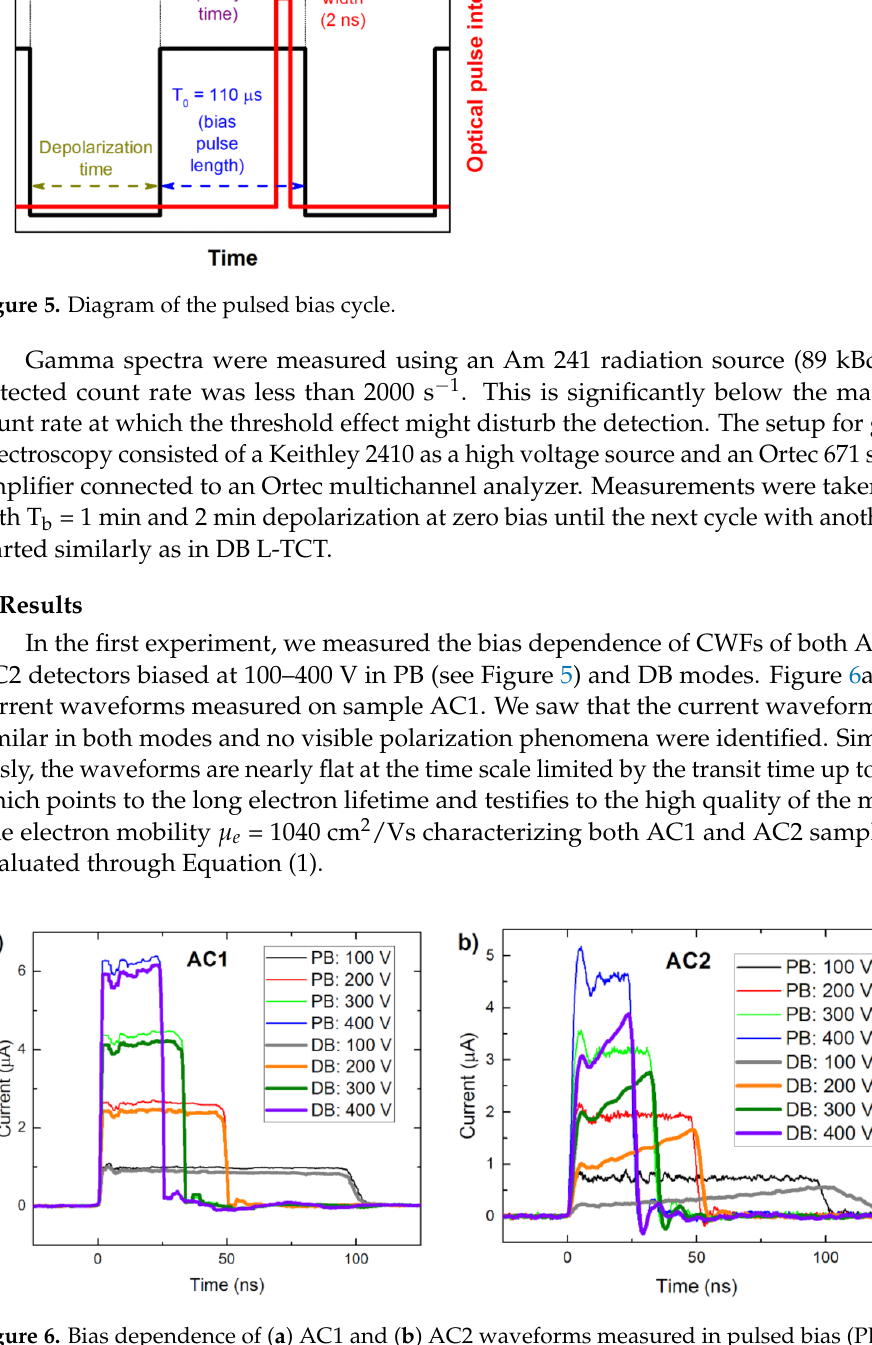
Figure 6. Bias dependence of ( a ) AC1 and ( b ) AC2 waveforms measured in pulsed bias (PB) mode and direct bias (DB) mode after 1 min